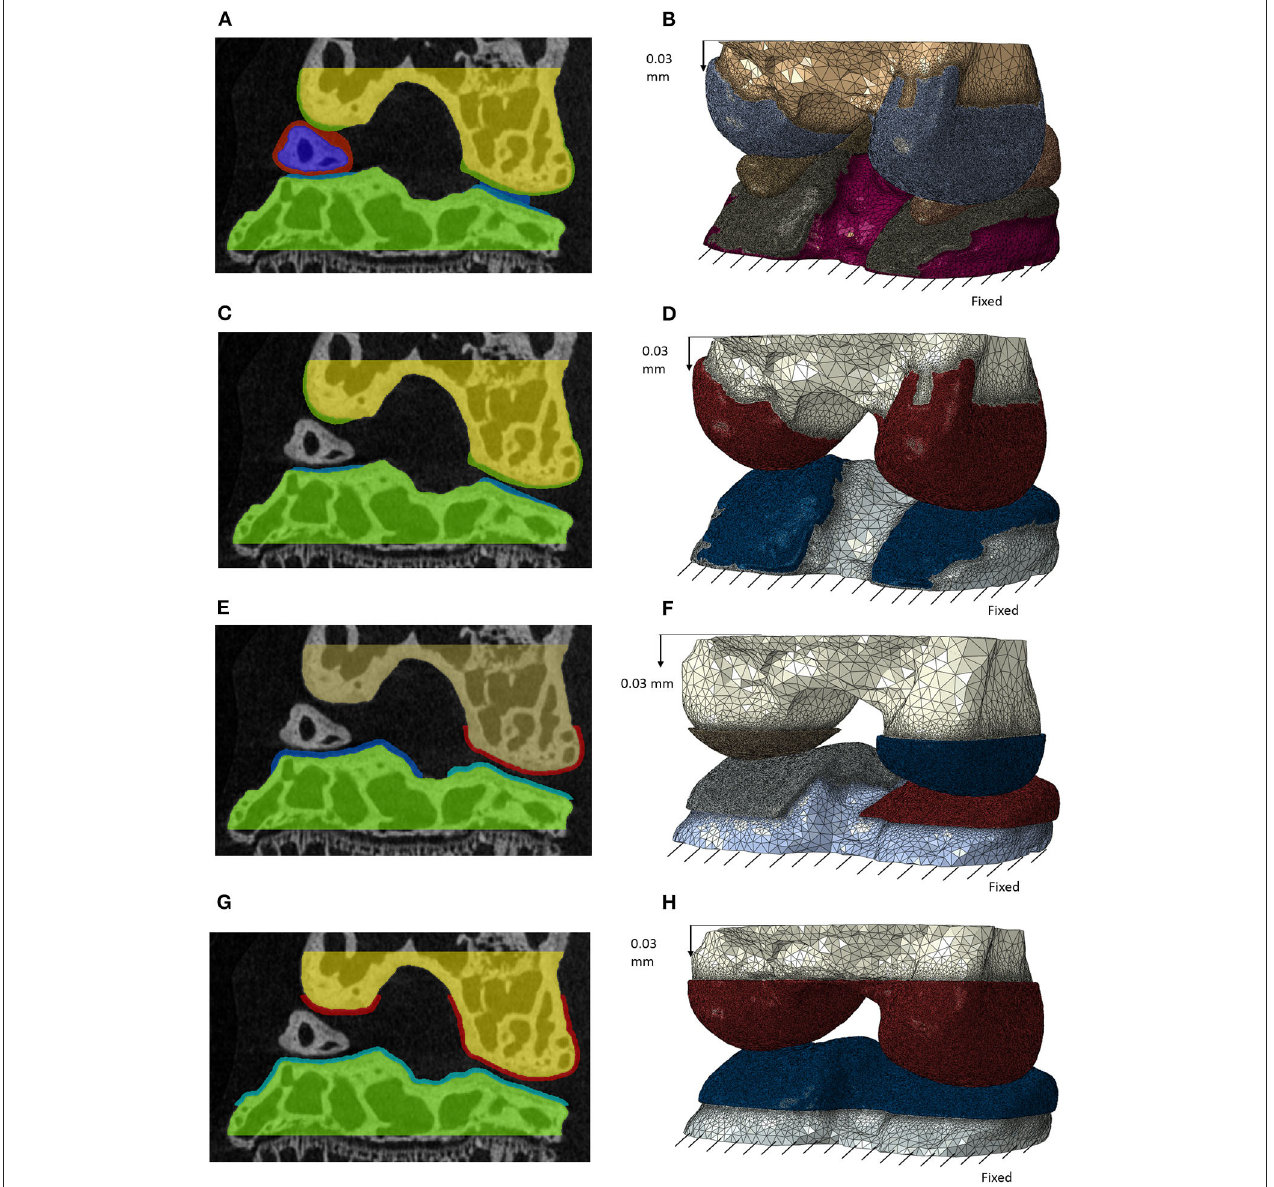
FIGURE 2 | Masks of the features for the different models with decreasing complexity in frontal section (left) and the generated finite element models after meshing (right) for: model including individual cartilage layers with meniscus (A,B) ; model including individual cartilage layers without meniscus (C,D) ; model including homogeneous cartilage layers with different thickness values for the lateral and medial condyles (E,F) ; model including homogeneous cartilage layer with the same value of thickness for both condyles (G,H) . In image (E) the cartilage is not visible for the medial condyle due to the chosen cutting plane. A supplementary image is included to show this layer (Supplementary Figure 1)